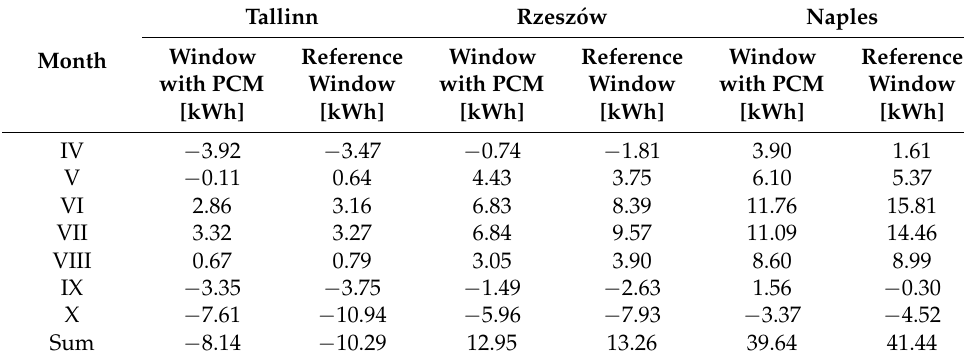
Table 3. Heat balances through windows with a PCM accumulator and reference windows operating in cool temperate (Tallinn), temperate (Rzesz ó w) and subtropical (Naples) climates. Tallinn Rzesz ó Month